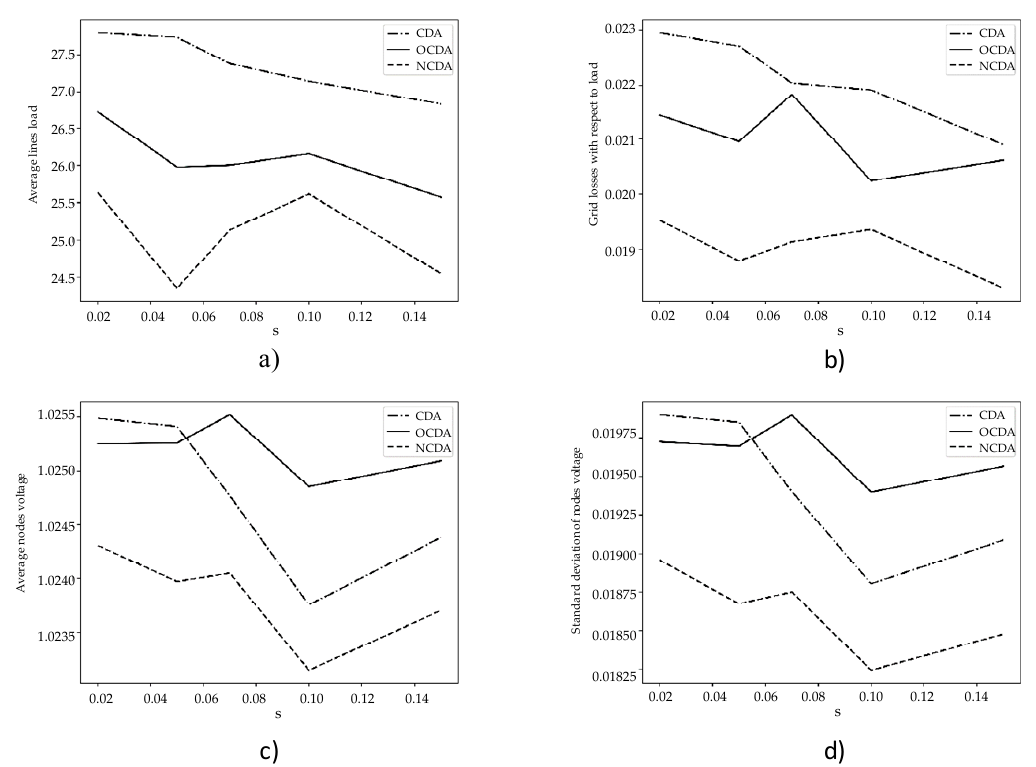
Figure 7. The evolution of network stability index for CDA, OCDA and NCDA for varying system variability s: ( a ) Average lines load, in percentage; ( b ) network losses, expressed as a fraction of network load; ( c ) average nodes voltage, in p.u.; ( d ) standsard deviation of node voltages, in p.u.